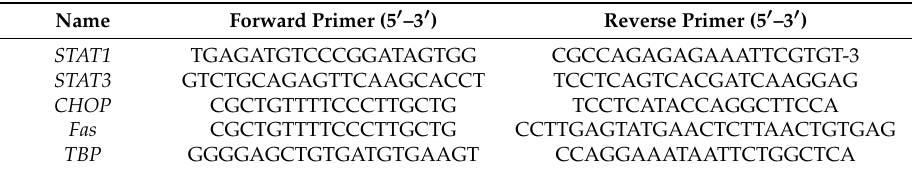
Table 1. Primers used for RT-PCR